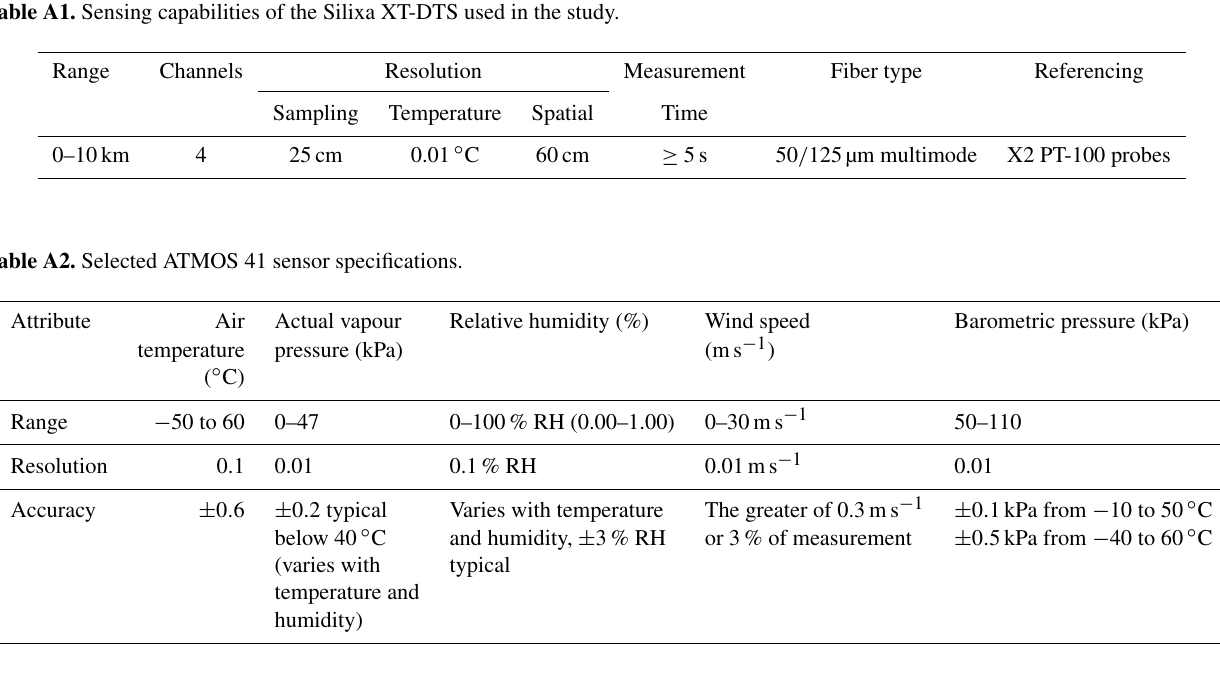
Table A1. Sensing capabilities of the Silixa XT-DTS used in the study.